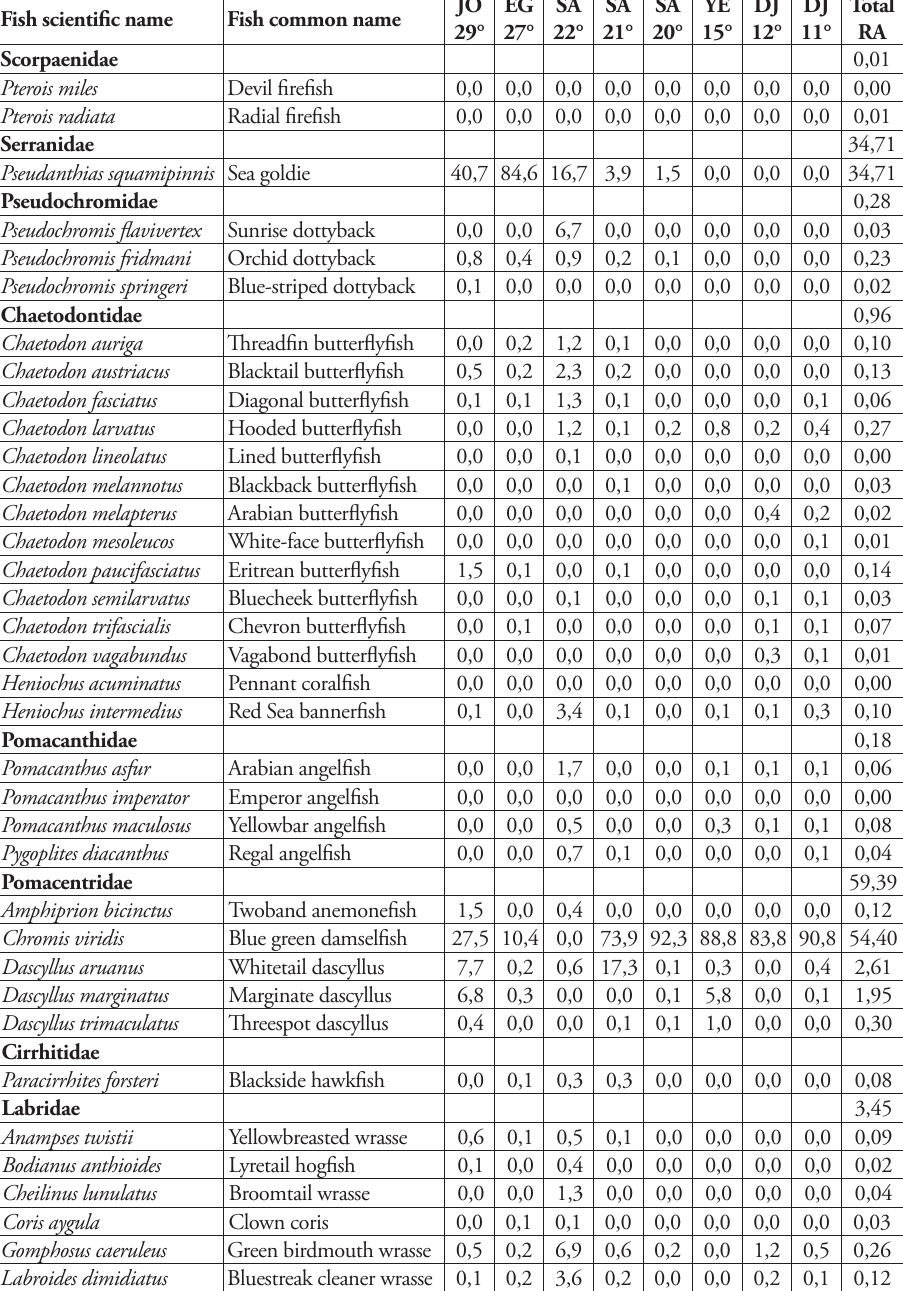
table 2. Relative abundance in % of fish individuals per 500m² transect along reefs at JO= Jordan lati- tude 29°; EG=Egypt latitude 27°; SA=Saudi Arabia latitude 22, 21, 20°; YE=Yemen 15° and DJ=Djibouti latitude 12, 11°. (TRA indicates total relative abundance per